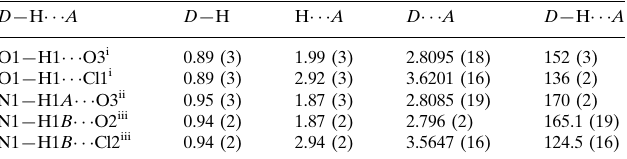
Hydrogen-bond geometry (A˚ , (cid:3)